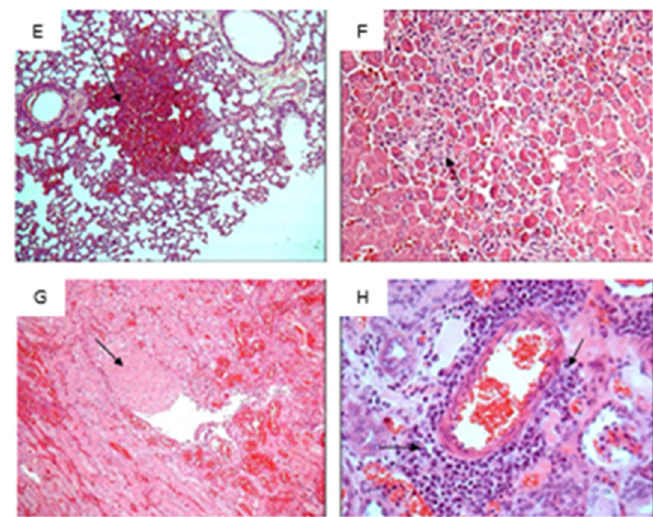
Figure 6. Pathology assessment of lungs from experimentally infected hamsters (Panels ( A – D )), and HE 100X histopathology of the lung (Panel ( E )), liver (Panel ( F )), and kidney (Panels ( G,H )) of a hamster in the negative control group D (IFA). Panel ( A ): Lung of a survival hamster in group A (rGspDLC alone); Panel ( B ): Lung of a survival hamster in group B (rGspDLC-IFA); Panel ( C ): Lung of a survival hamster in group C (serovar Canicola bacterin); Panel ( D ): Lung of a dead hamster in group D (IFA); Panel ( E ): Pulmonary hemorrhage; Panel F: Hepatocellular degeneration and necrosis and inflammatory infiltration; Panel ( G ): Renal vascular thrombosis; ( H ): Renal perivascular inflammatory infiltration, mainly composed of lymphocytes and plasmatic cells.